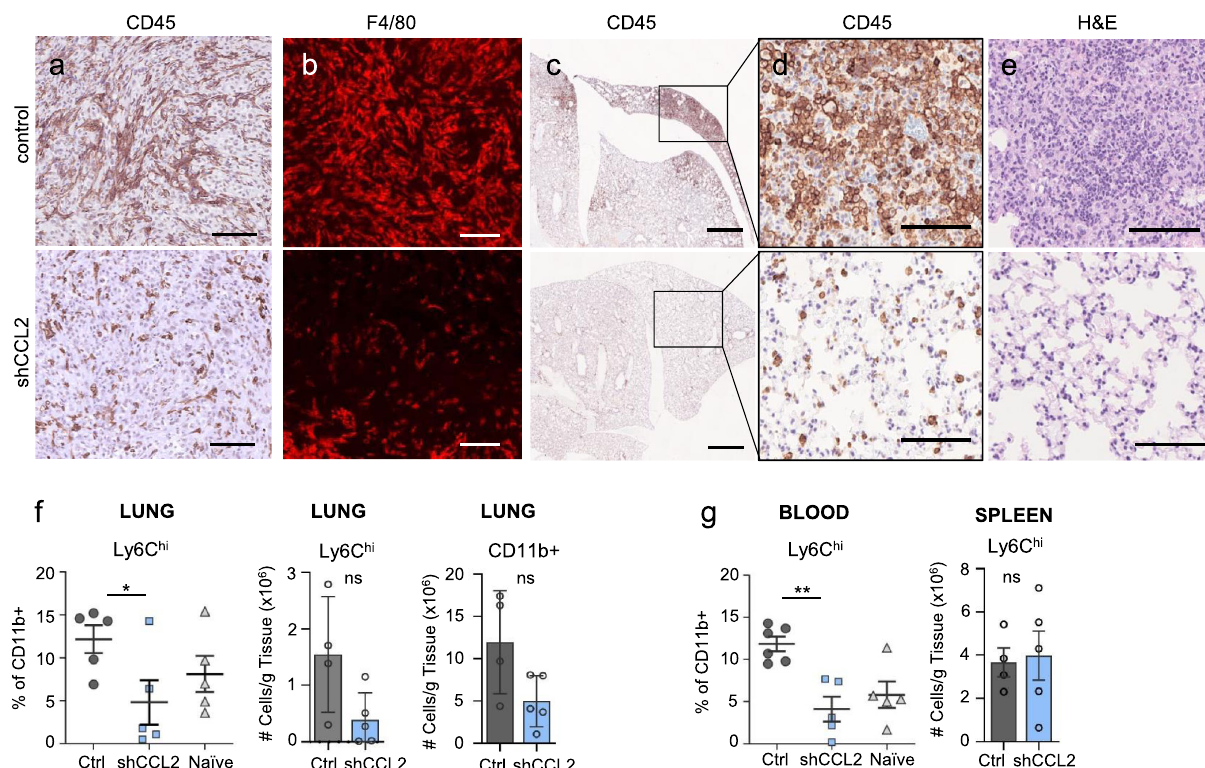
Fig. 9 Local and systemic effects of CCL2 knockdown in A3250 tumors. Immunostaining of A3250-control and A3250-shCCL2 tumors for CD45 ( a ) and F4/80 ( b ) as indicated. c – e Lungs of mice bearing A3250-control or A3250-CCL2 tumors at 4 weeks post-injection (~40 mm 3 volume), immuno-stained for CD45 ( c , d ) or stained for H&E ( e ). Flow cytometry analysis of CD11b + and Ly6C hi cells in lungs ( f ), blood and spleen ( g ) from A3250 tumor-bearing (control), A3250-shCCL2 and naïve mice. f left panel, n = 5 biologically independent samples for each group, p = 0.0158; f middle and right panels, n = 4 A3250-control and n = 5 A3250-shCCL2 biologically independent lung samples. g left panel, n = 6 A3250-control and n = 5 for A3250-shCCL2 and tumor-naïve independent blood samples, p = 0.0011; ( g ) right panel, n = 4 A3250-control and n = 5 A3250-shCCL2 biologically independent spleen samples. Black lines on the plots indicate mean values± SEM. ( f – g ), left panels: performed a two-sample t test to determine signi fi cance; ( f ), center and ( f – g ), right panels: signi fi cance was determined through a Mann – Whitney non-parametric t test. Images are representative of two independent experiments. n = 3 biologically independent mice. All scale bars: 100 μ m, except ( c ), 1 mm. ** p < 0.01, * p < 0.05; ns, not signi fi cant. Source data are provided as a Source Data fi